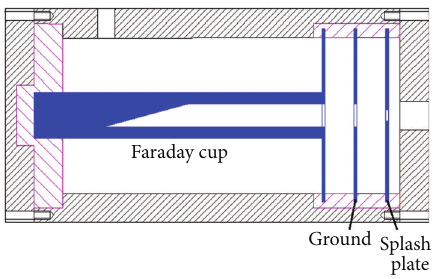
Figure 5: The 2D AutoCAD drawing of the Faraday cup.